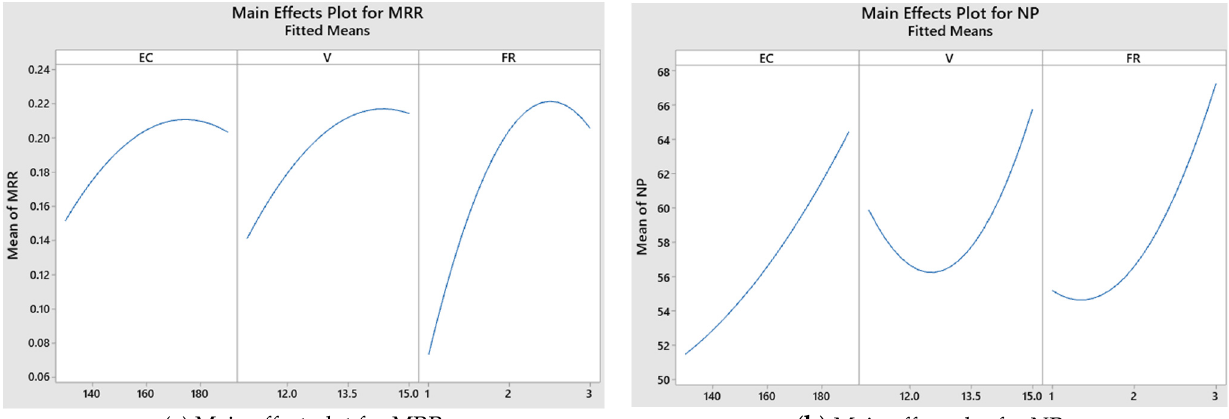
Figure 9. Main effects plots of MRR and NP